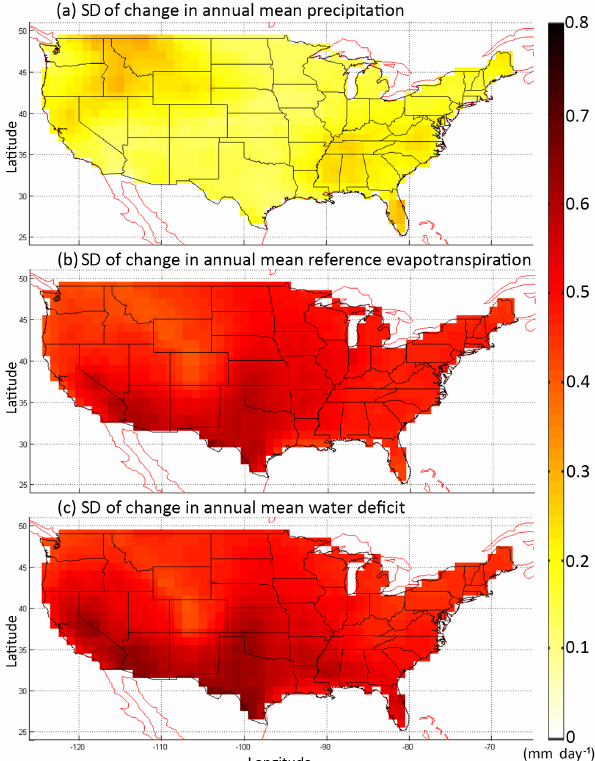
Figure 3. The standard deviation of the change in the annual mean (a) P , (b) ET 0 , and (c) P –ET 0 over the US. All units are mmday − 1 and the change is defined as the average of 2070–2100 minus that of 1950–2005. The standard deviations are estimated over all GCMs, ET 0 estimation methods, and RCP